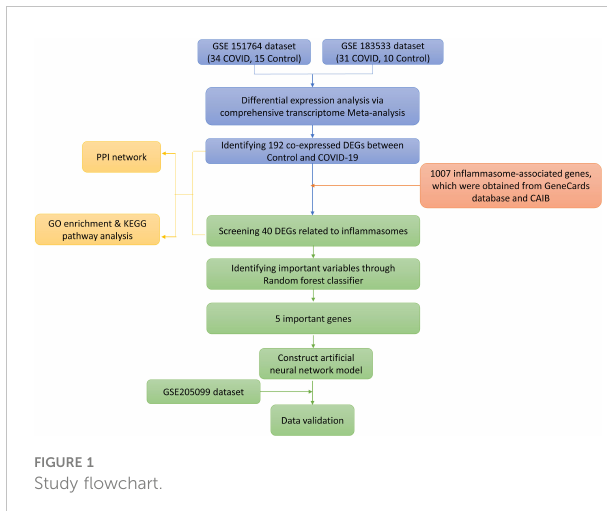
FIGURE 1 Study fl